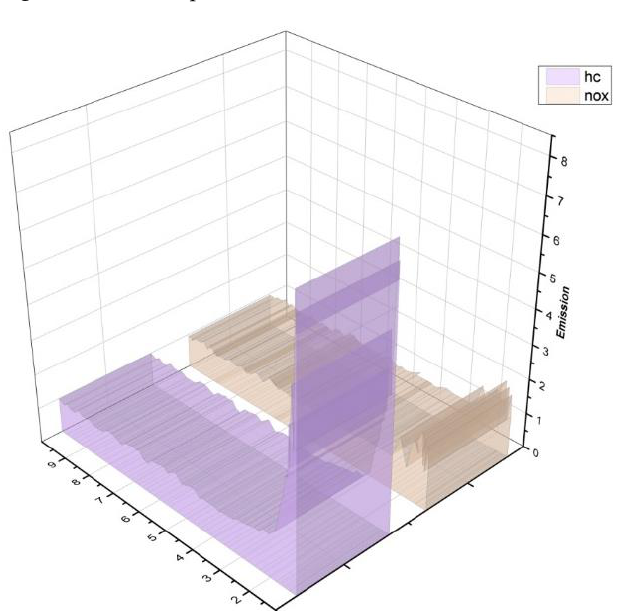
Figure 11. Exhaust gas emissions.